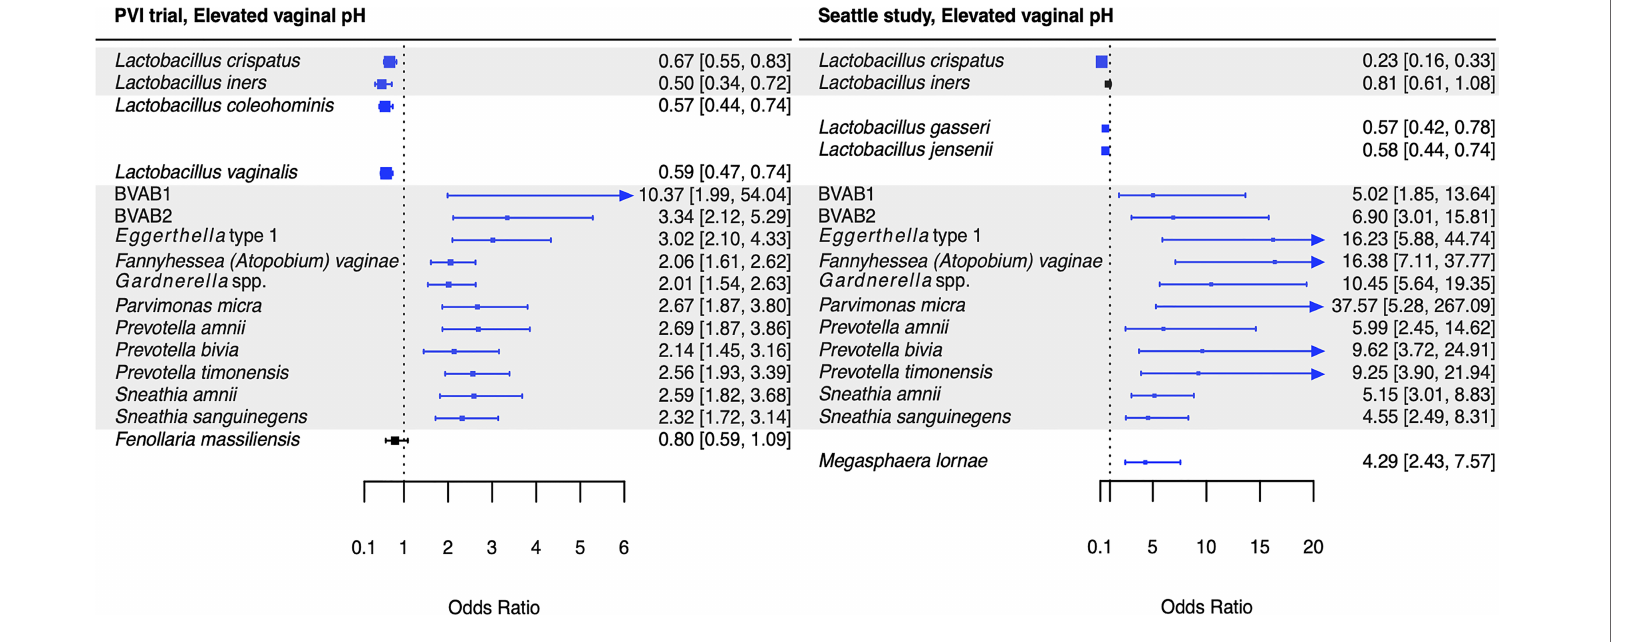
FIGURE 5 | Logistic regression modeling results for the association between vaginal bacteria and elevated vaginal pH. Gray shading indicates taxa that were modeled in both study populations. Blue box and whiskers indicate associations that were signi fi cant following Benjamini-Hochberg multiple comparisons adjustment (5% false discovery rate), and black box and whiskers indicate associations that were not signi fi cant following multiple comparisons adjustment. All models were univariable logistic regression models with the Amsel criterion as the outcome and bacterial relative abundance as the exposure. Bacterial relative abundances were modeled as tertiles with the reference level being no detection (four-level ordinal variables with levels: no detection, tertile 1, tertile 2, tertile 3). Generalized estimating equations with an independent correlation structure were used for PVI trial models, and no variables were lagged in PVI models. PVI, Preventing Vaginal Infections; OR, odds ratio; CI, con fi dence interval; BVAB, bacterial vaginosis associated